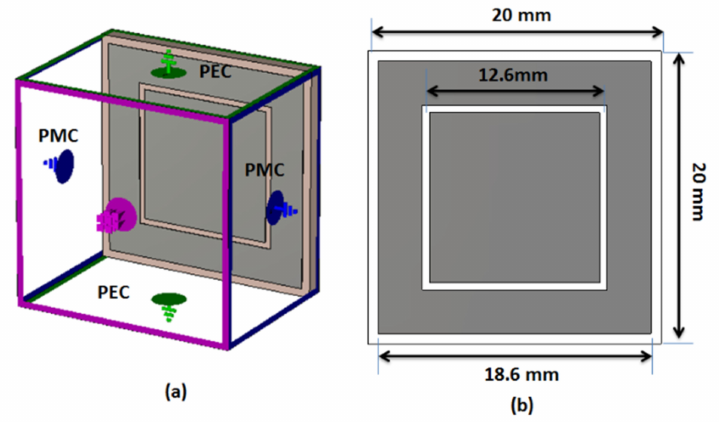
Figure 7. AMC structure ( a ) with boundary conditions and the ( b ) 2-D configuration.